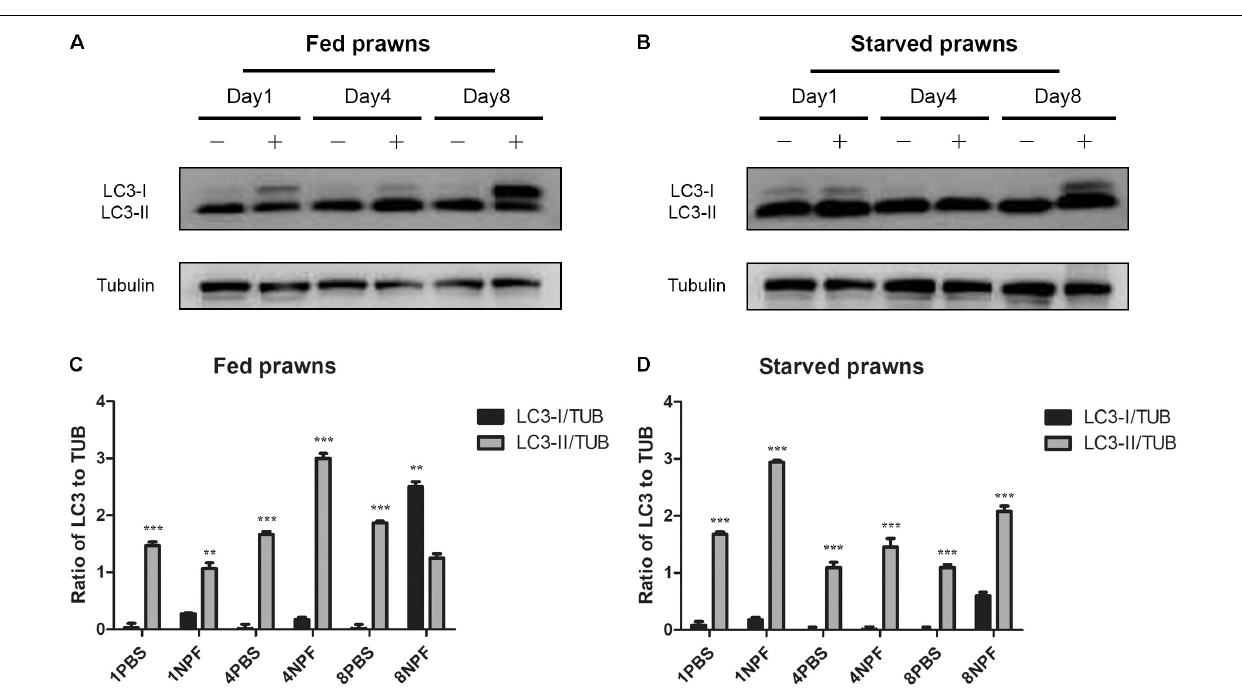
FIGURE 4 | Effect of neuropeptide F on the expression of LC3 in the hepatopancreas. (A) Western blots of the autophagy markers, LC3I and LC3II, in the hepatopancreas of fed prawns injected with 0.1 M PBS (–) or neuropeptide F (+) at days 1, 4, and 8. (B) Western blots of LC3I and LC3II of starved prawns injected with 0.1 M PBS (–) or neuropeptide F (+) at days 1, 4, and 8. (C) Densitometric ratios of LC3 normalized with alpha tubulin of fed prawns from A ( N = 8). (D) Densitometric ratios of LC3 normalized with alpha tubulin of starved prawns from B ( N = 8) ( ∗ P < 0.05, ∗∗ P < 0.01, ∗∗∗ P <